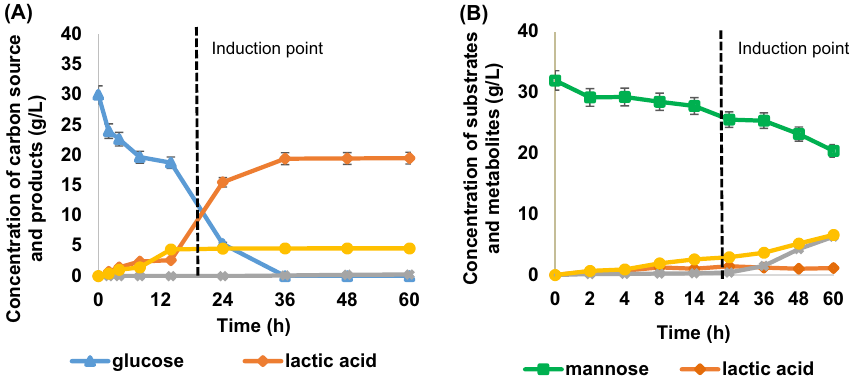
Figure 8. The time-course profile of batch fermentation of lactic acid production with substrate ( A ) glucose and ( B ) mannose.